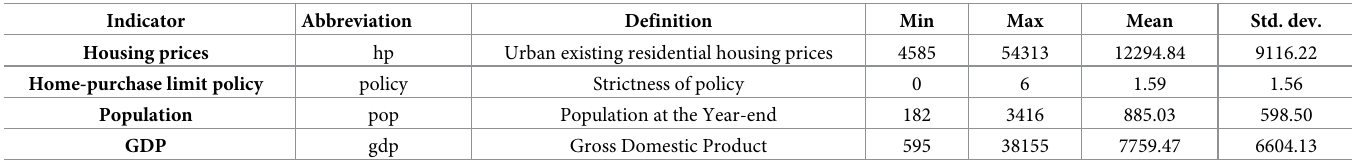
Table 2. Definitions of variables and descriptive